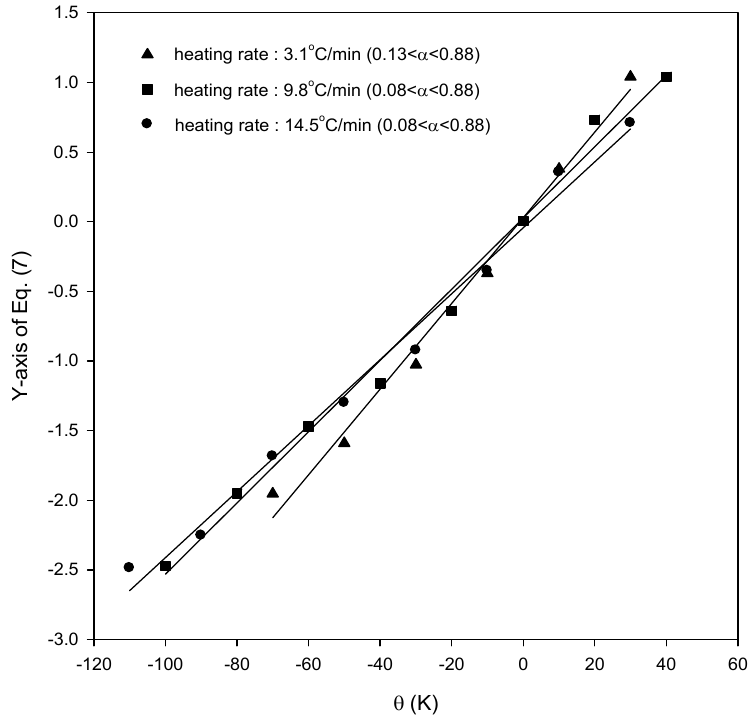
Figure 3. Plots of Equation (7) for the application of kinetic analysis for